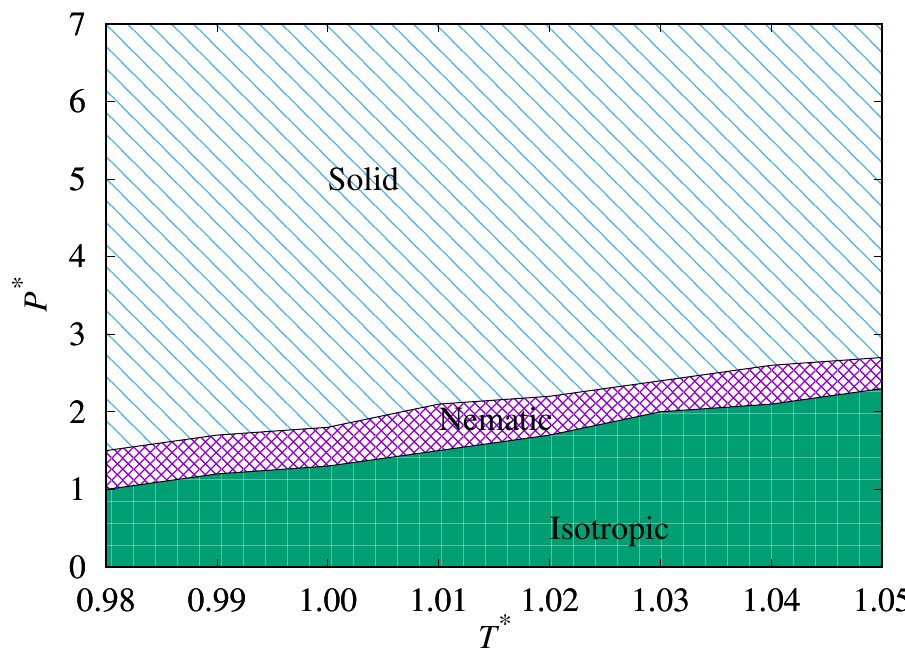
Figure 7. Phase diagram plots for phase transition lines predicted from replica-exchange MC for the upward ( top ) and downward ( bottom ) branches.